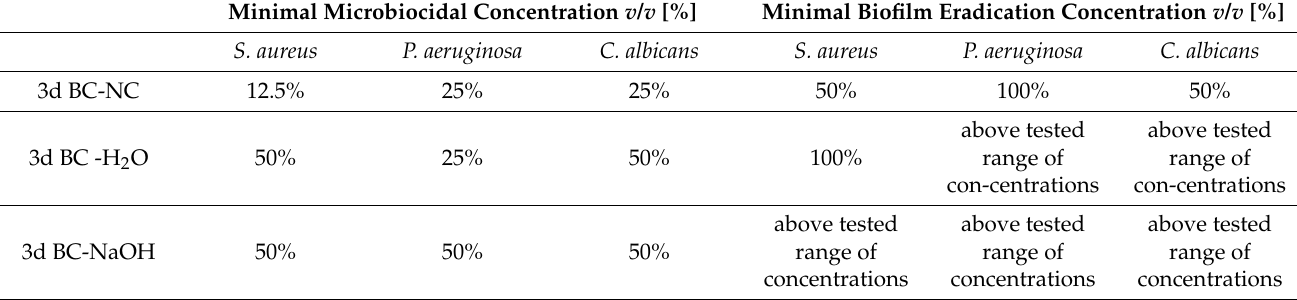
Table 3. Minimal Antimicrobial Concentration and Minimal Biofilm Eradication Concentration of liquid obtained from NBC matrices.